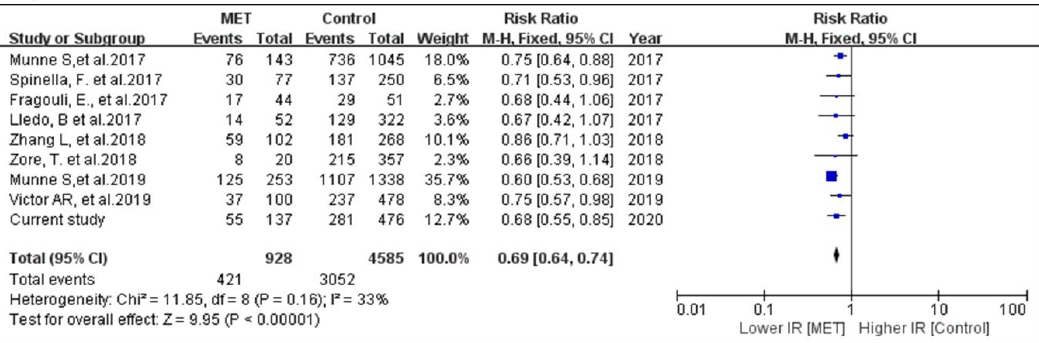
Figure 3. Meta-analysis of the comparison of ongoing pregnancies/live birth rates. Meta-analysis performed by the random effect model due to the fact that p -value of the heterogeneity test was less than 0.1. In the overall assessment of miscarriage rate, 102 mosaic (420 embryo population) and 360 euploid (2819 embryo population) embryos were reported as miscarriage. Given that the overall heterogeneity showed no difference with p = 0.17, this comparison was analyzed by a fixed model. The probability of miscarriage in MET is significantly higher than the control group (RR = 1.96, 95% CI: 1.61–2.39, p < 0.001; nine studies; I 2 = 32%, p = 0.17) (Figure 4).